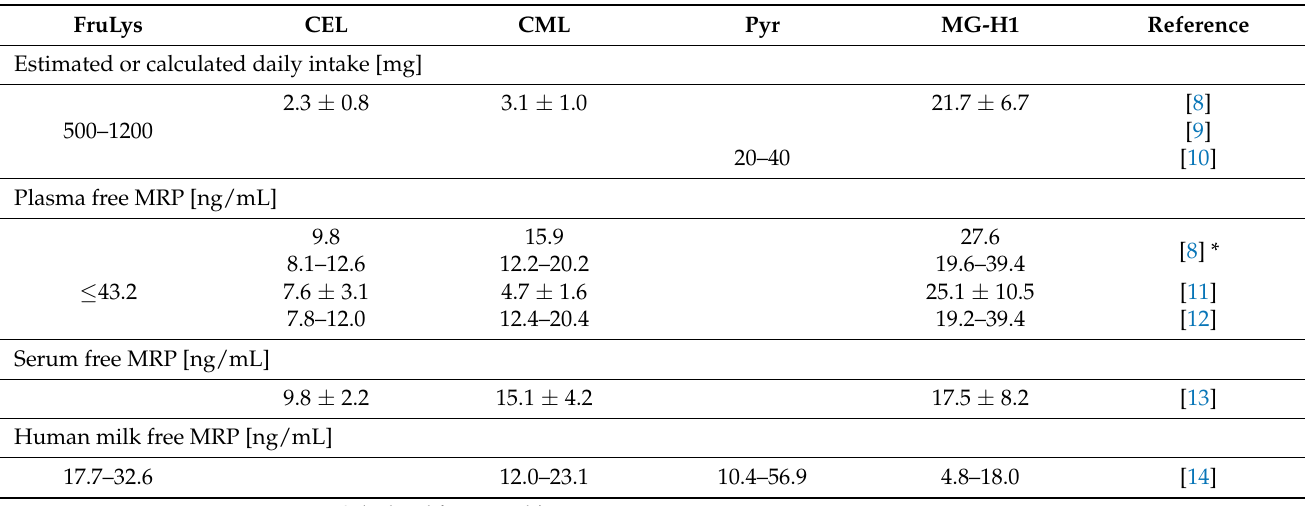
Table 1. Estimated daily intake of Maillard reaction compounds from food and concentrations in different human body